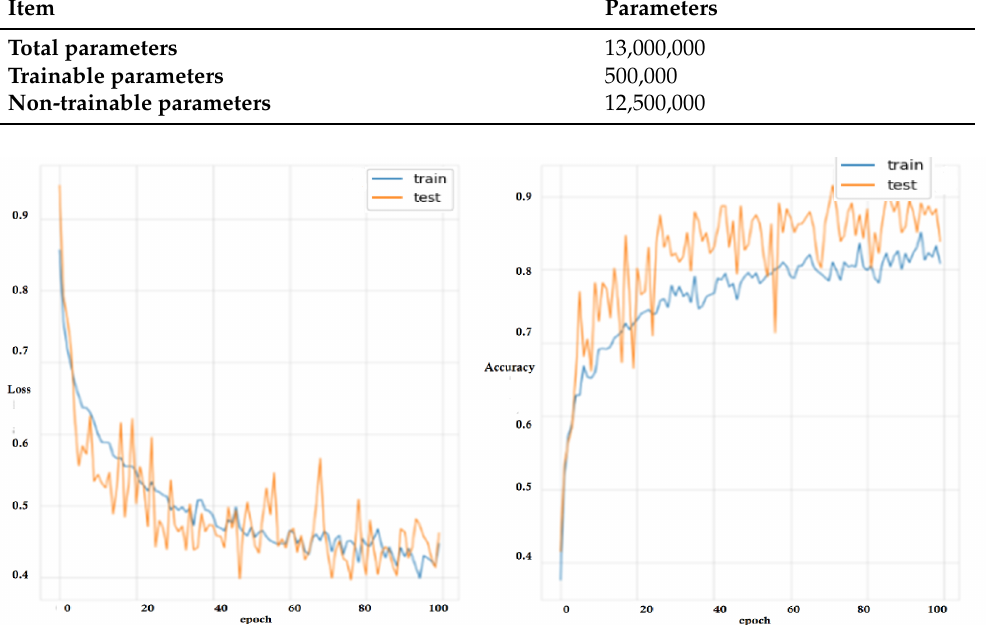
Figure 12. Classification Loss and Accuracy using